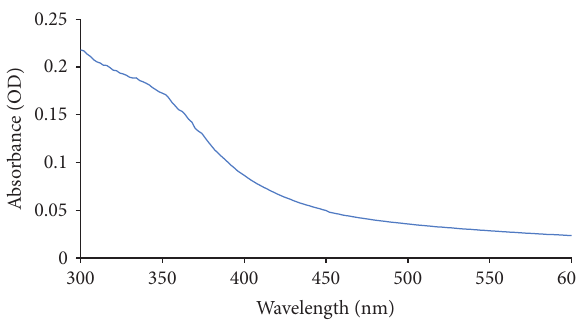
F 1: Flower of A. wilhelmsii plant.